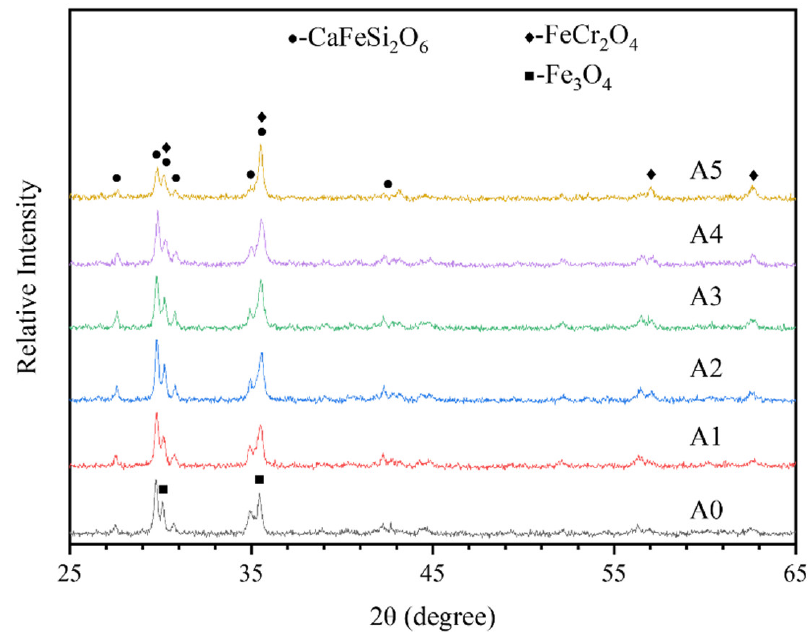
Figure 1. XRD analysis results of adding different Cr 2 O 3 content to CaO-SiO 2 -Fe t O system.